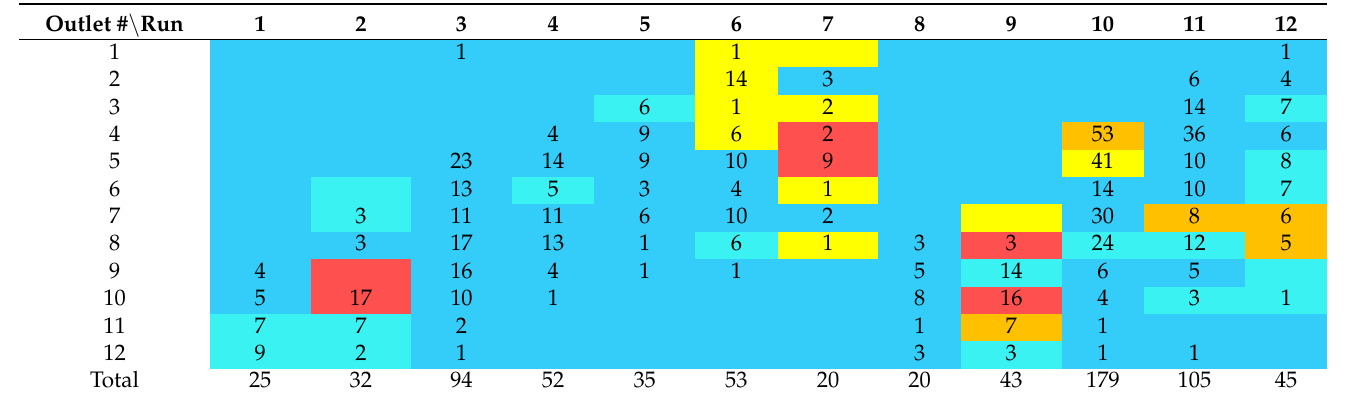
Table 1. The particle distribution throughout the outlets across the twelve runs. The blank spaces represent zeros. The absolute difference of the program versus manual count is color-coded by